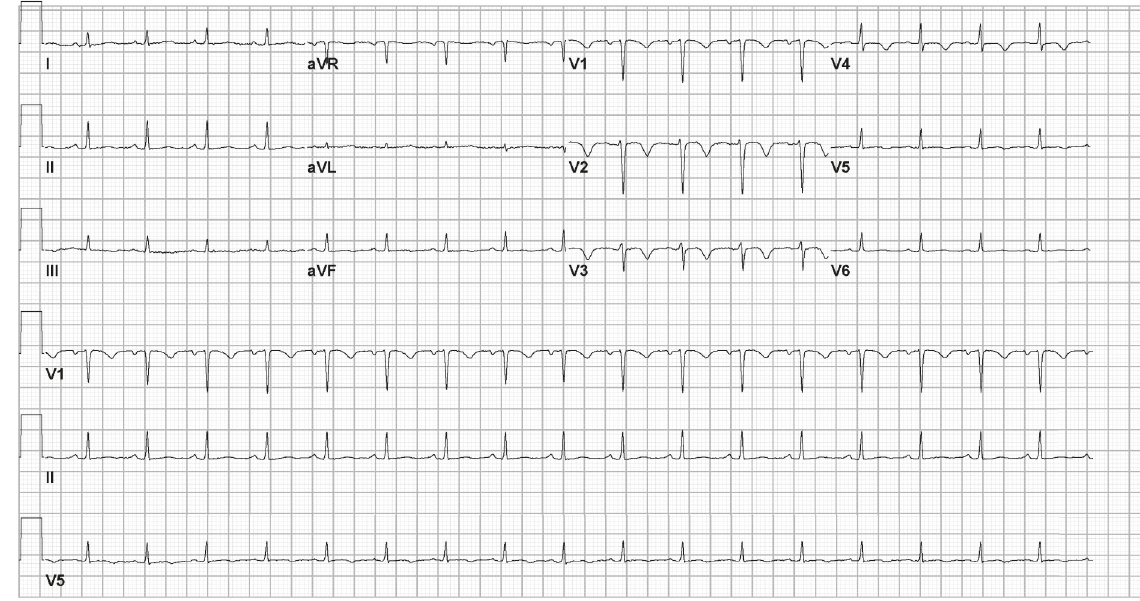
Figure 1: Wellen’s T waves in leads V1-V4 consistent with a possible stenosis in the left anterior descending coronary artery.